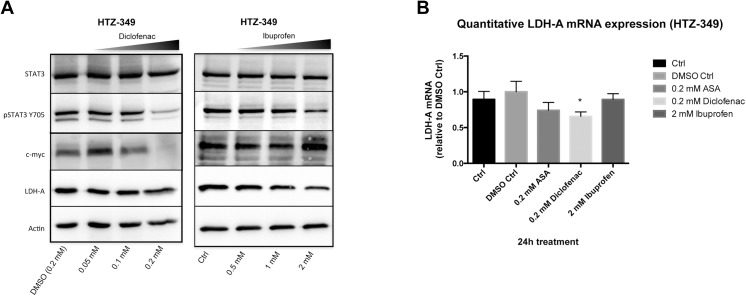
Ibuprofen and diclofenac affect STAT-3 signalling differentially.Transcription factors within the STAT-3 signalling pathway were investigated by Western blot (40 μg of protein) after incubation with increasing ibuprofen (0.5, 1, 2 mM) or diclofenac concentrations (0.05, 0.1, 0.2 mM) for 24 h. (A) Ibuprofen and diclofenac reduced STAT-3 phosphorylation in HTZ-349 cells without affecting total STAT-3 levels (for detailed quantification see S5 Fig). The STAT-3 downstream target c-myc was significantly upregulated by ibuprofen (S5A Fig), whereas diclofenac blocked pSTAT-3 and c-myc in a concentration-dependent manner (S5B Fig). LDH-A, a direct target of c-myc, showed negative trends, but not to significant extent. Corresponding quantitative RT-PCR revealed significant LDH-A transcript decrease with diclofenac (0.2 mM, compared to control and DMSO control, 95% CI, * = 0.05 > p ≤ 0.01). Ibuprofen (2 mM) had no impact on LDH-A expression (B). Similar observations were made with ASA (0.2 mM). Corresponding results for A172 and U87MG were generated (see S6 and S7 Figs).